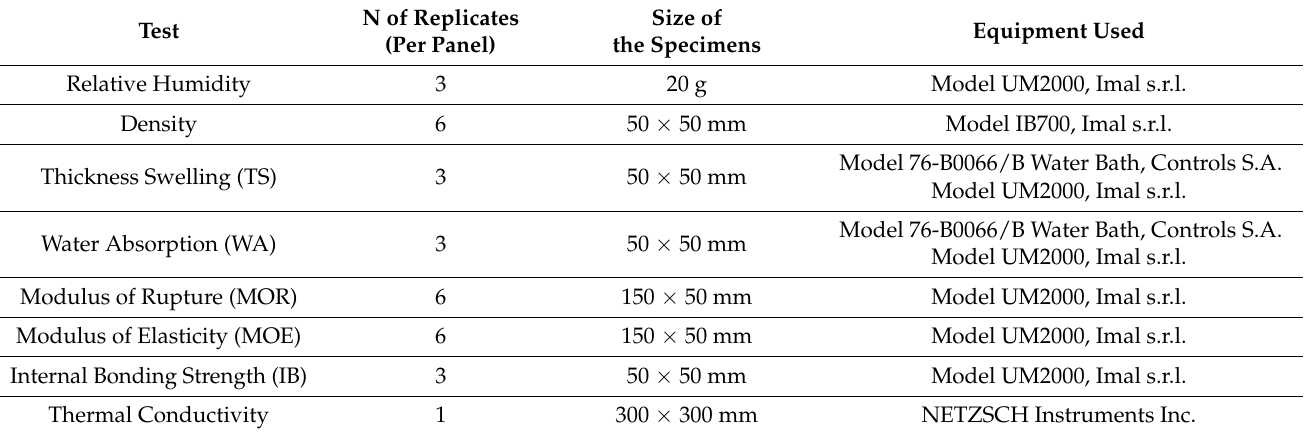
Table 2. Characteristics of the tests performed.